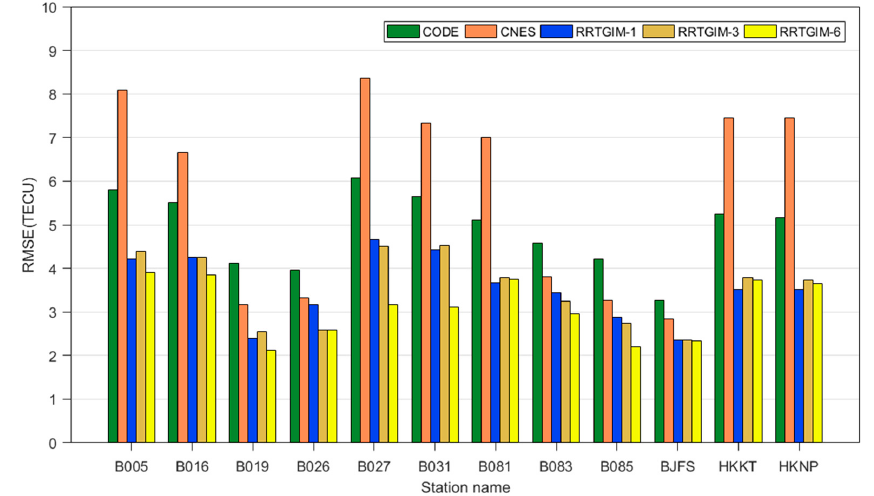
Figure 11. Slant total electron content (STEC) RMSE of CODE, CNES, and RRTGIMs on DOY 78, 2020.